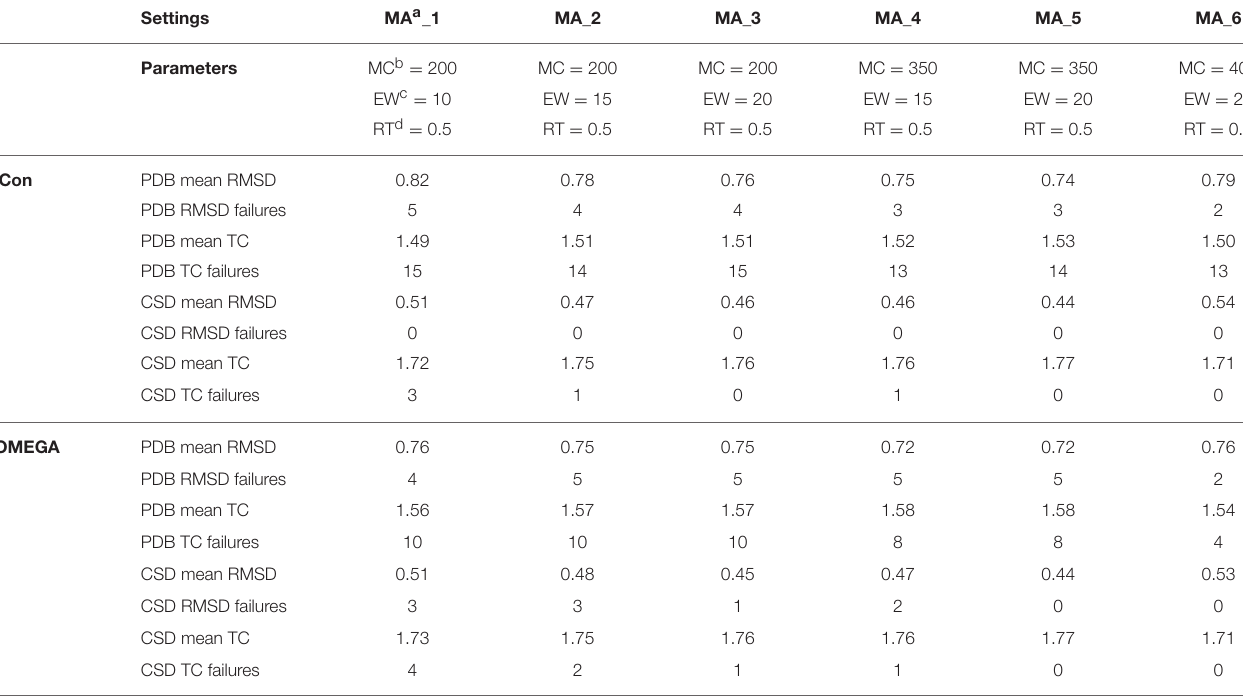
TABLE 3 | Mean RMSD and TC score values obtained for PDB and CSD data set compounds by using iCon and OMEGA with medium accuracy settings. Settings